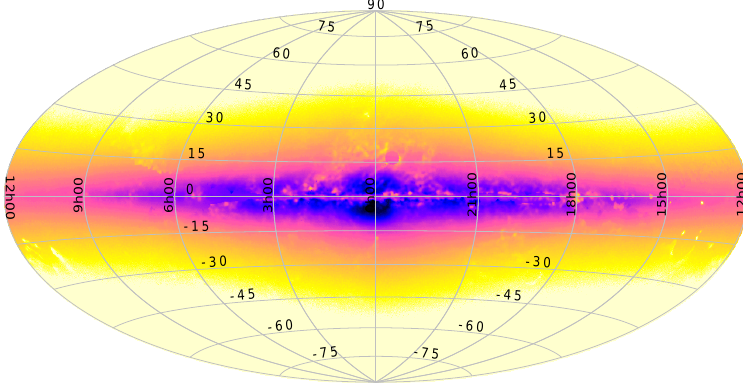
Figure 8. Plot of a large table: A map representing simulated density on the sky of stars in the Milky Way [26]. This figure (originally from [25]) was generated from a 2 billion row table in about 30 min on a normal desktop